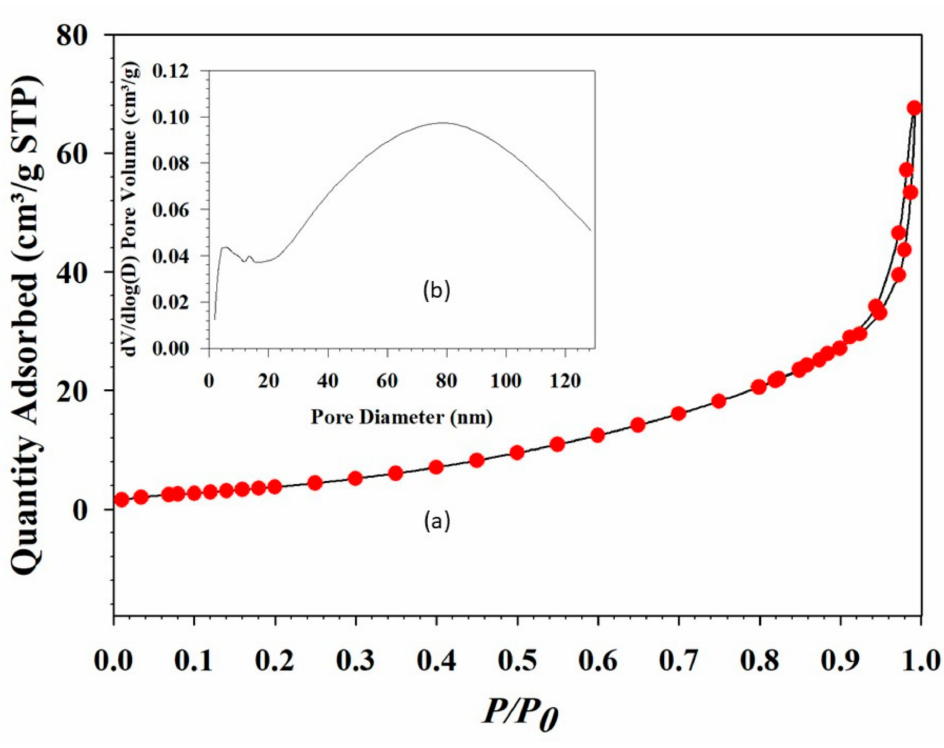
Figure 6. ( a ) Nitrogen adsorption-desorption isotherms of the as-synthesized 10-MCC and ( b ) Inset of the Figure shows the diameter of the pores present in the same